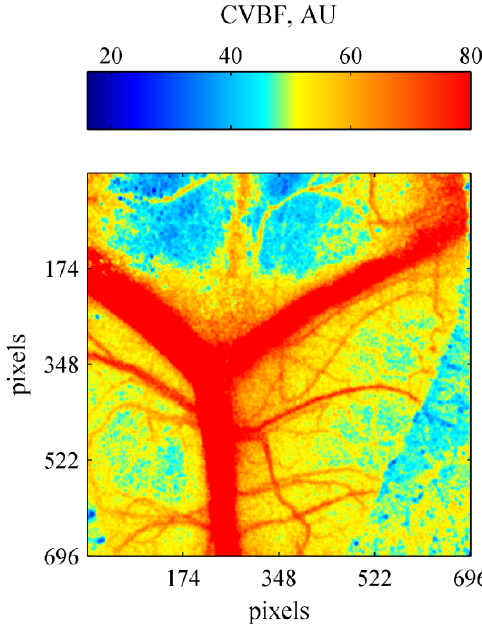
Fig. 1. An example of speckle contrast image of the superior sagittal sinus